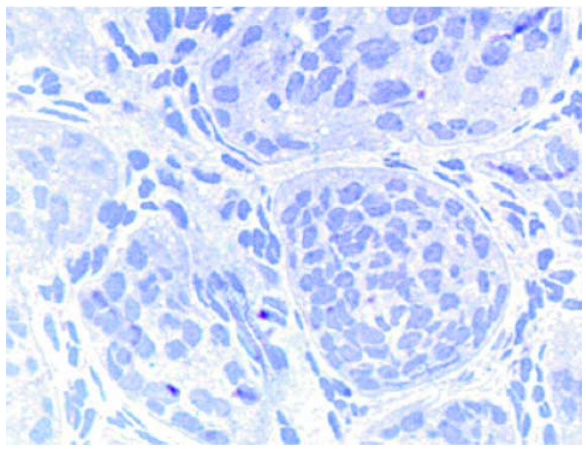
Figure 2 – Photomicrography of testicular parenchyma of a treated patient (toluidin blue,